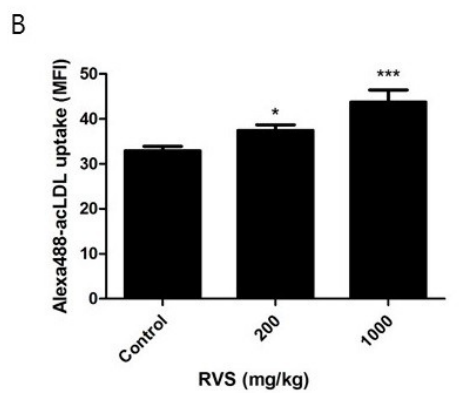
Figure 2. Effects of RVS extract on scavenger receptor activity in peritoneal macrophages. Peritoneal exudate cells isolated from thioglycollate-injected mice were cultured overnight. After removal of non-adherent cells, the remaining adherent cells were incubated with Alexa Fluor 488-labeled labeled acetylated low-density lipoprotein (acLDL) for 4 h and analyzed via flow cytometry. ( A ) Representative histograms are shown. ( B ) The bars represent the mean ± SEM ( N = 6). MFI: mean fluorescence intensity. Statistical differences between groups were determined using Student’s t -test. * p < 0.05, *** p < 0.005 vs. control.